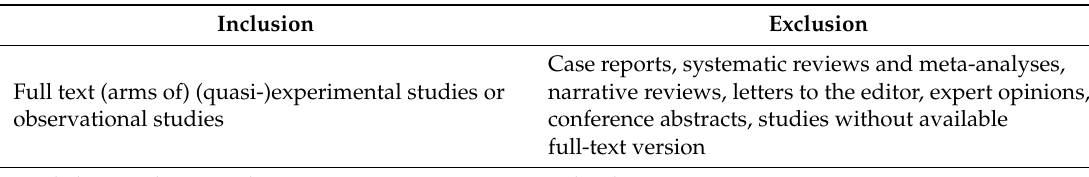
Table 1. Eligibility